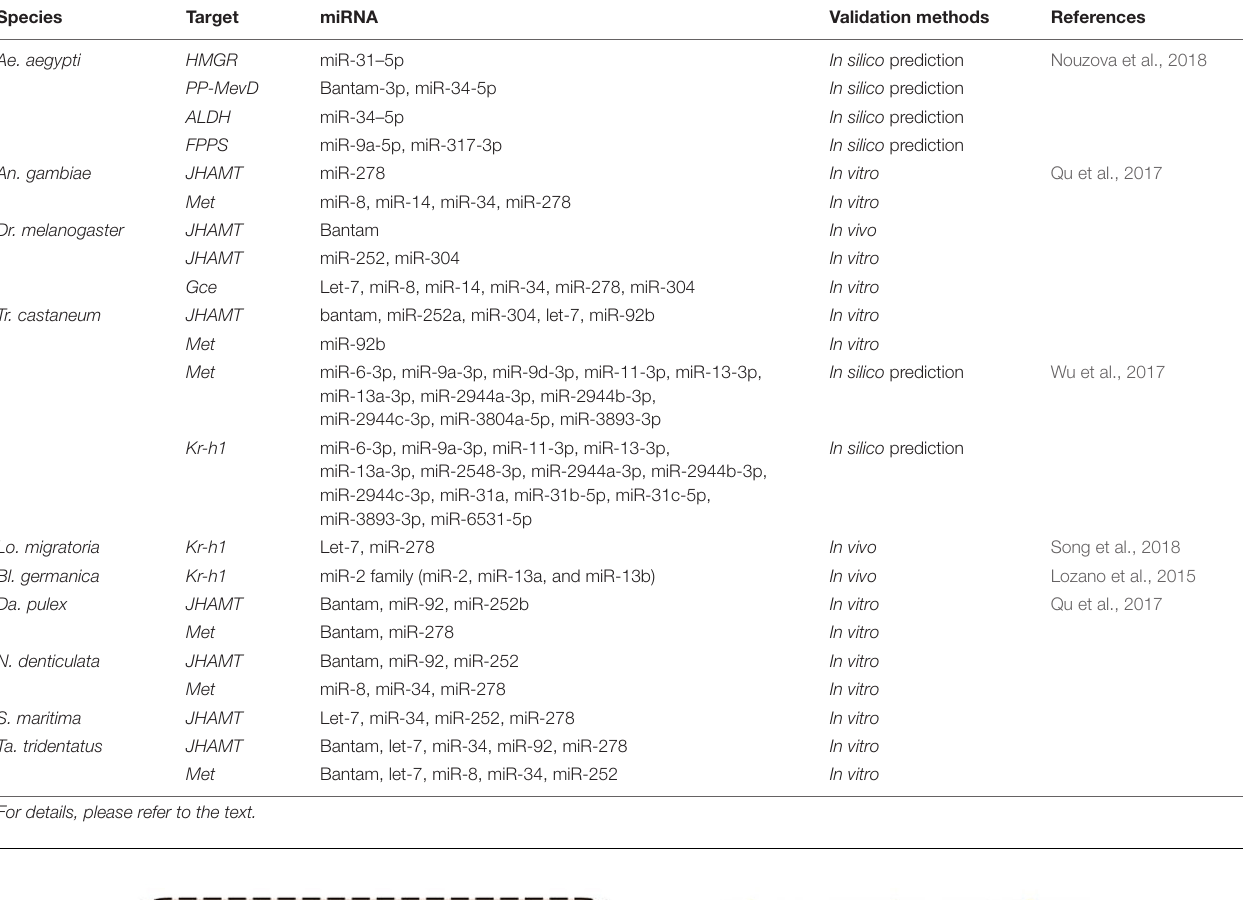
TABLE 2 | Published studies of potential microRNA regulators on insect sesquiterpenoid pathway genes. Species Target